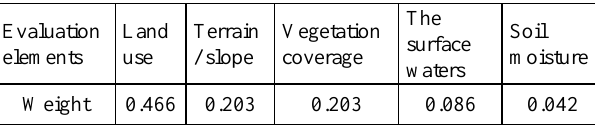
Table 3 Weights of evaluation